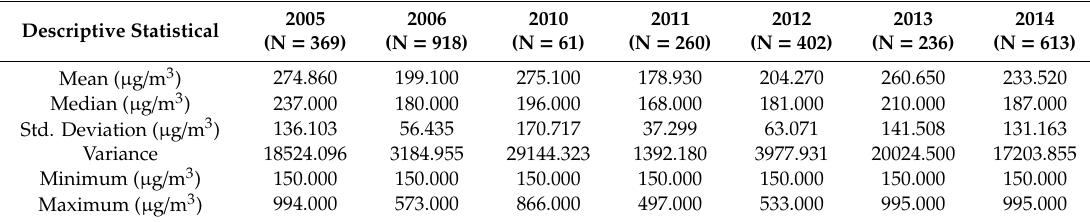
Table 2. Summary of descriptive statistics during periodic haze events in